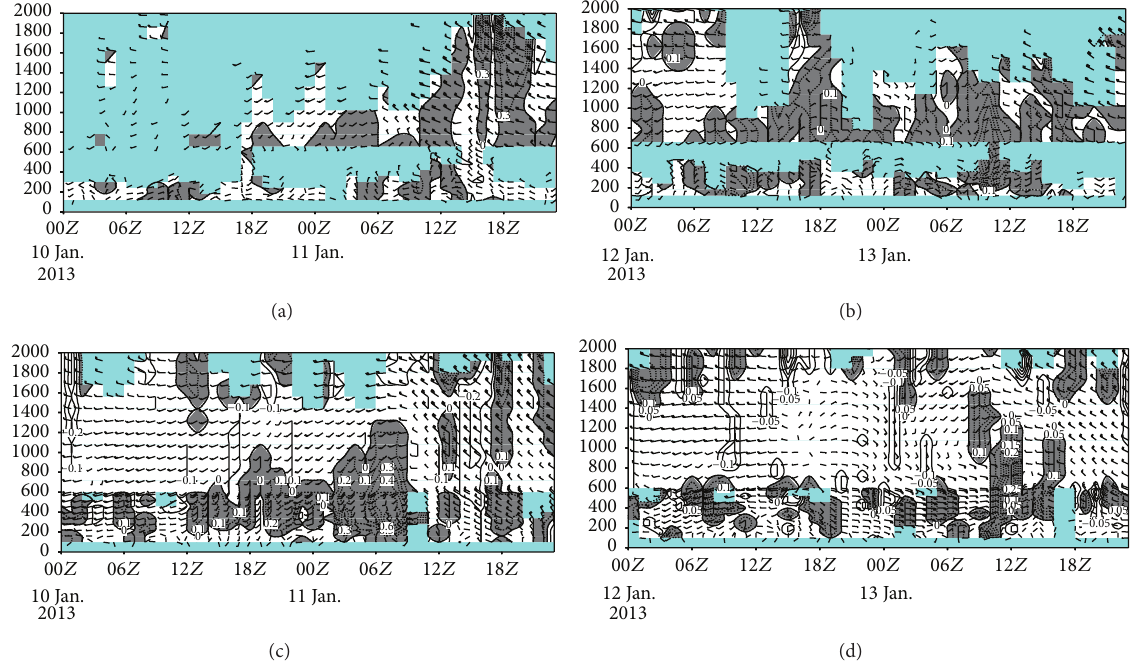
Figure 11: Wind profile (horizontal vector wind and vertical wind speed (unit: m/s)) in Beijing ((a) and (b)) and Tianjin ((c) and (d)) from January10to13.Theshadedmapisverticalwindspeed,whiterepresentsascendingmotionwithspeed < 0 m/s,andgrayrepresentsdescending motion with speed > 0 m/s.